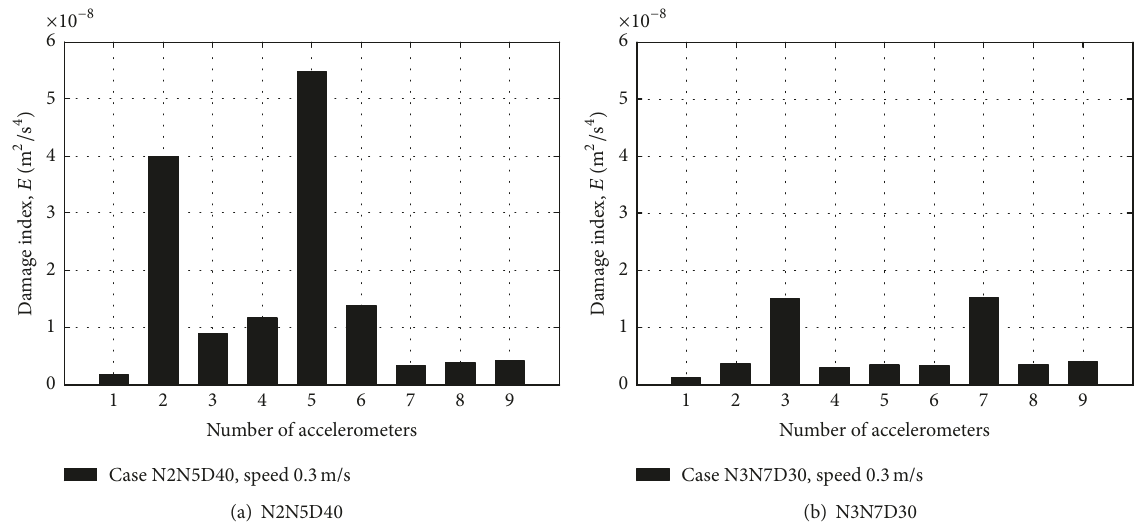
Figure 18: Scalar values of the damage index 𝐸 𝑛 for all accelerometers for the multiple damage scenarios: (a) case N2N5D40 (velocity = 0.3 m/s) and (b) case N3N7D30 (velocity = 0.3